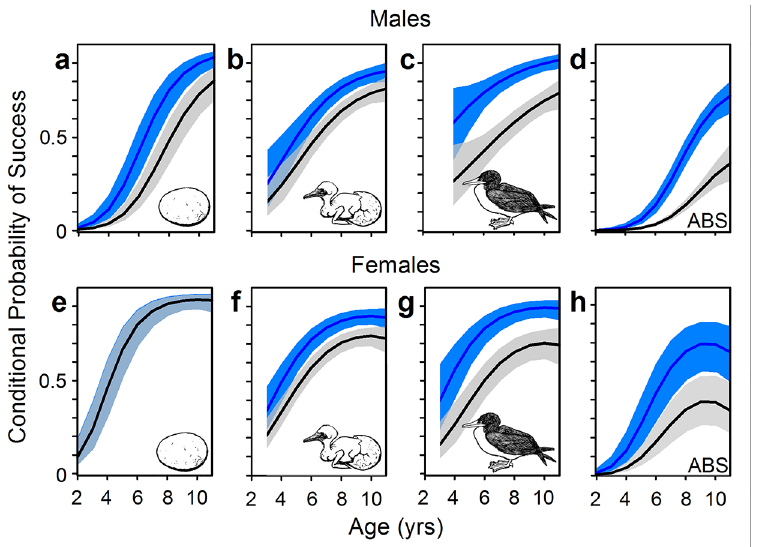
Fig 4. Component stages of Annual Breeding Success of young and middle-aged adults by Fish Phase. Predictionsfor SardinePhase (blue) and Flying Fish Phase (gray) shown as in Fig 3. Data are derived only from the 12 yrs of the study with detailedhistorieson the componentsof each breedingattempt. See Methods for years involvedin each stage. Conditional probabilities for different stages are p(initiatea clutch | alive) (panelsa, e), p(hatch an egg | clutch was initiated)(panelsb, f), p(produceindependentoffspring | hatch) (panels c, g), and p(produce independentoffspring | alive) for only the subset of years for which analysisof components was possible(panels d, h). Samplesize varies by sex/response variable.Full model results given in S1, S2 and S7 Tables.